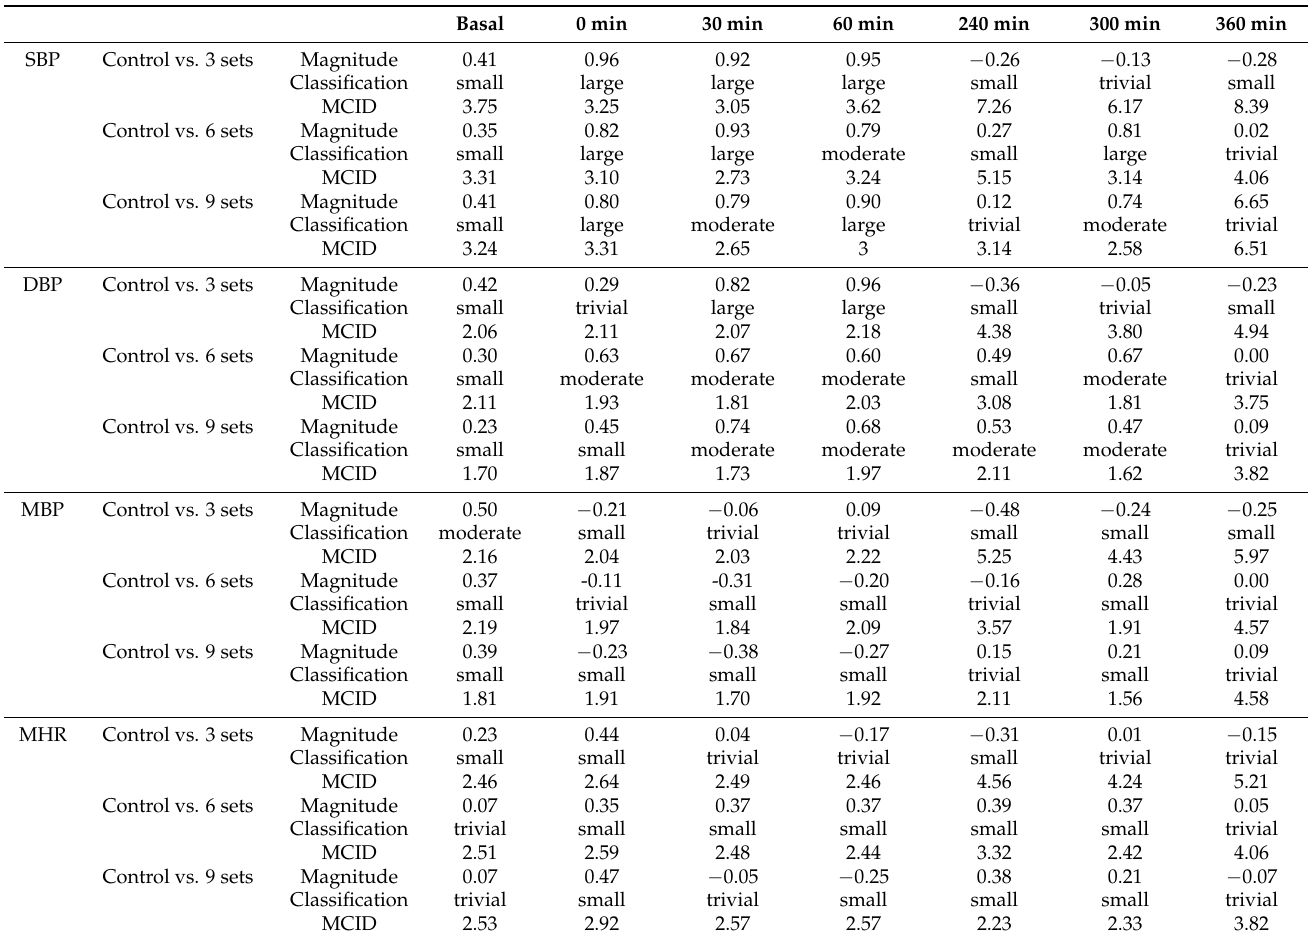
Table 5. Effect sizes of hemodynamic parameters after the different resistance volume